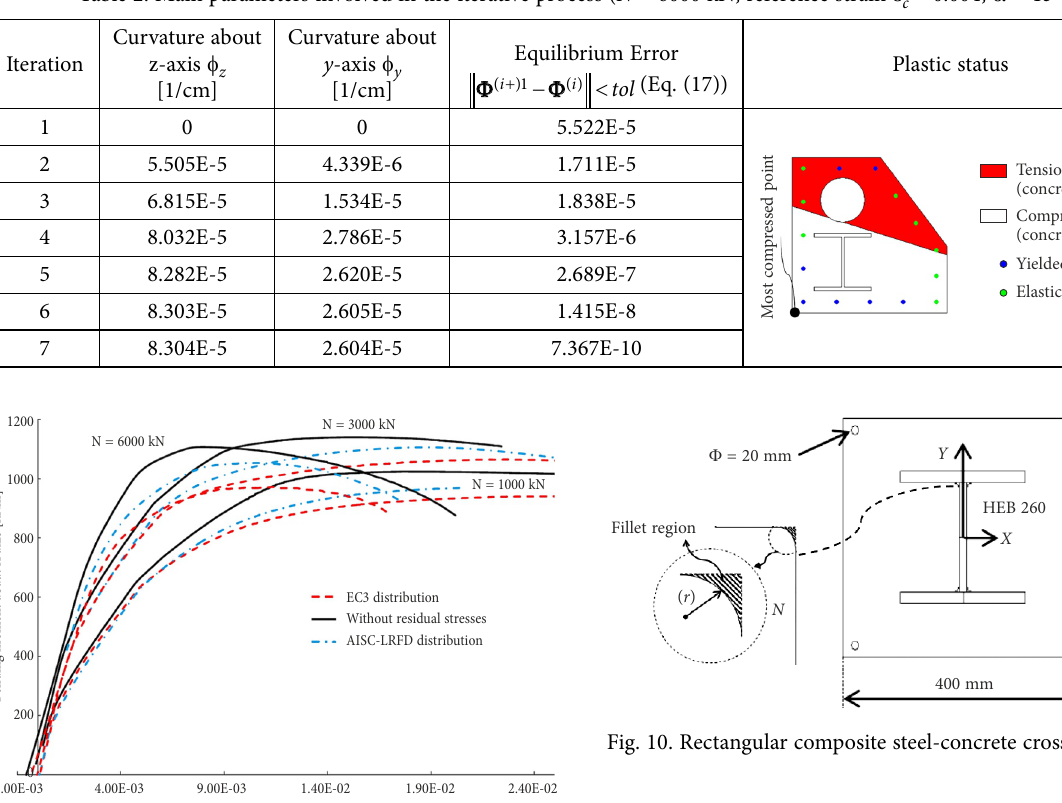
Fig. 9. Moment curvature diagrams for different values of compressive axial force: Influence of residual stresses